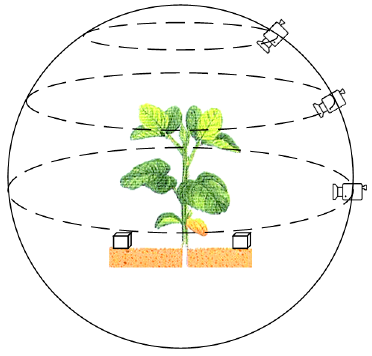
Figure 1. Video data collection method.